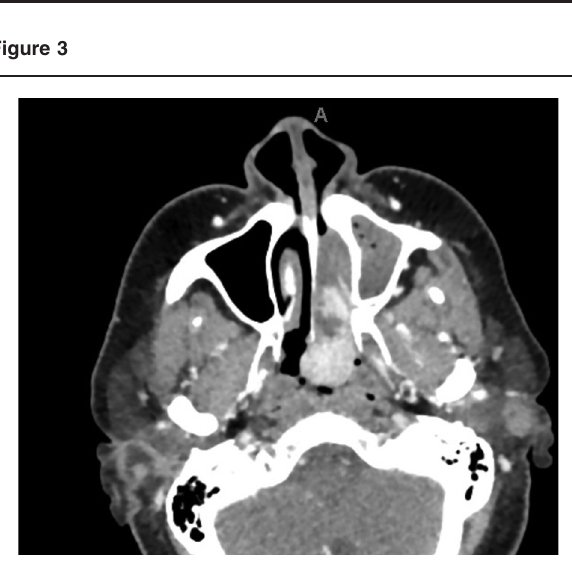
Axial computed tomography reconstructions postcontrast showing a hypervascular mass originating from the left nasal cavity, extending into the nasopharynx. into the left sphenoid and